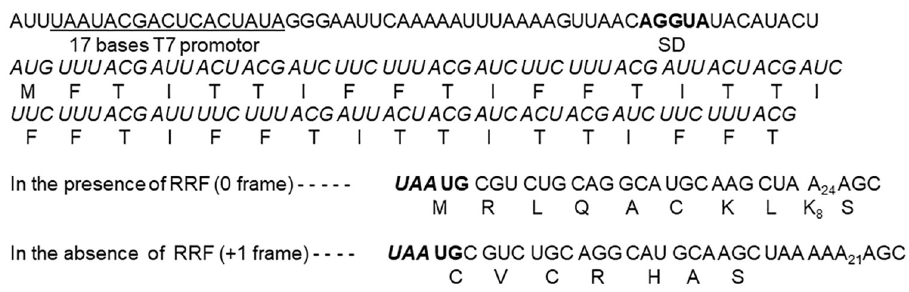
Fig 8. 027mRNA sequence and translated peptides. Two ways of downstream reading that depend on the presence or absence of RRF are shown. u-ORF is in italic. SD and the junction sequence are in bold. Amino acid residues corresponding to the triplets of the reading frames are shown in single capital letters.